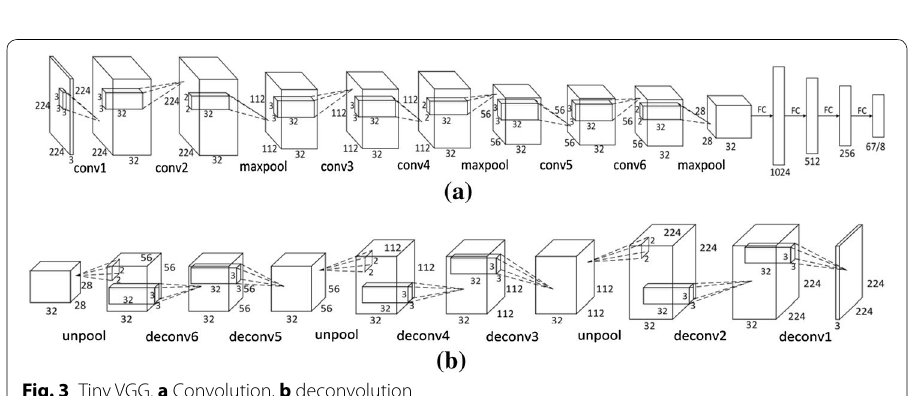
Fig. 3 Tiny VGG. a Convolution, b